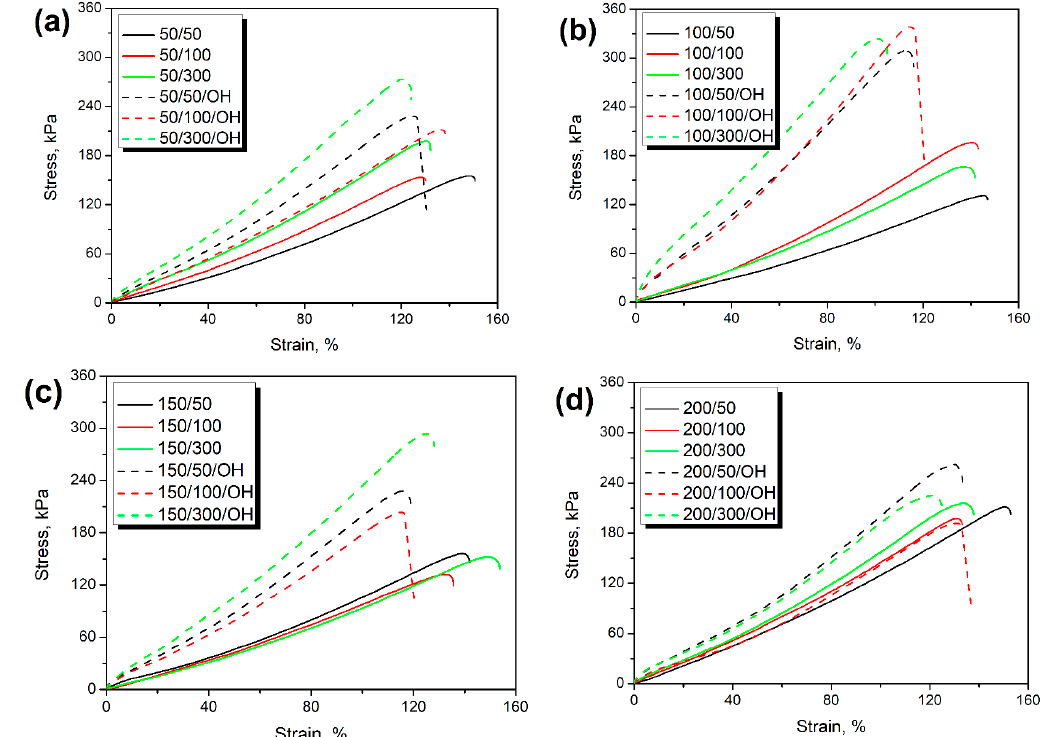
Figure 1. Stress-strain curves of composite foams containing GTR modified at ( a ) 50 °C, ( b ) 100 °C, ( c ) 150 °C, and ( d ) 200 °C.